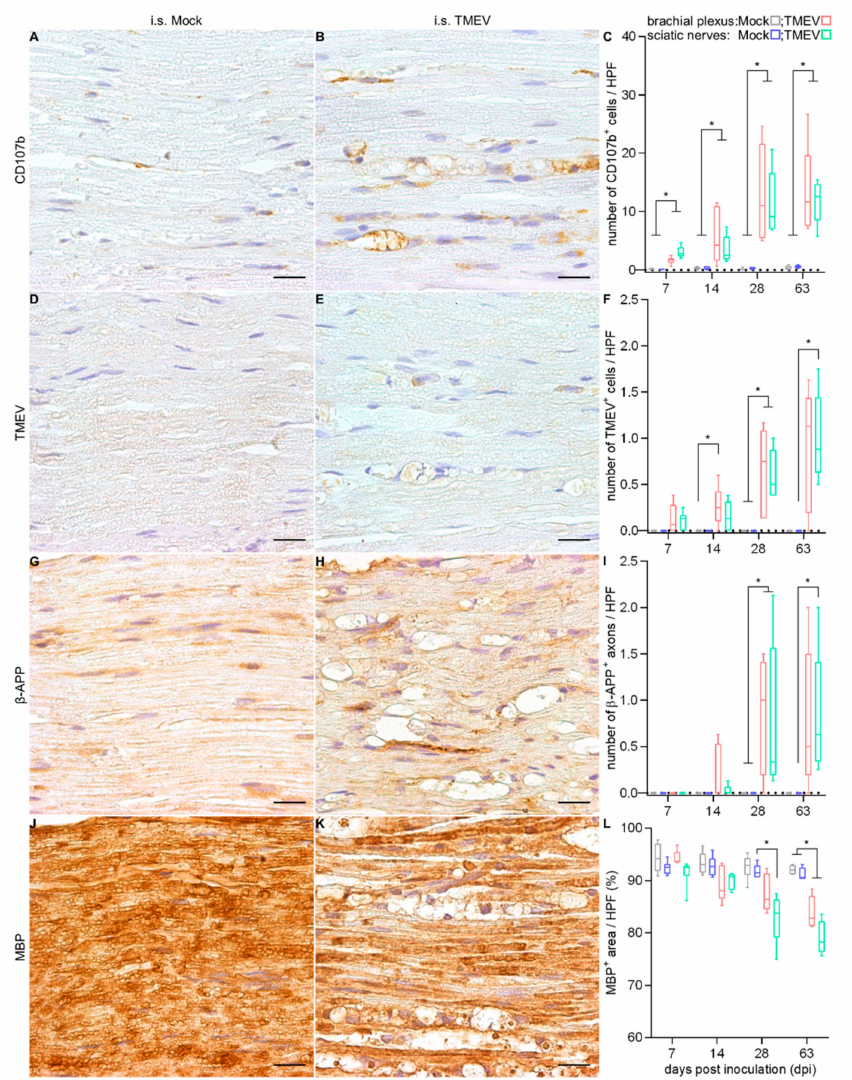
Figure 6. Detection of macrophages and myelinophages, TMEV, axonal damage and demyelination at 28 dpi in PN following i.s. mock-injection ( A , D , G , J ) and TMEV infection ( B , E , H , K ). Statistical analysis revealed a significant increase in the number of CD107b + macrophages ( C ) at all investigated time points. Virus protein was firstly detected at 7 dpi, while significant di ff erences started at 14 dpi ( F ). Significant axonal damage ( I ), as well as demyelination ( L ) following i.s. TMEV infection were initially seen at 28 dpi. Graphs show the average of left and right brachial plexus or sciatic nerves, respectively. Box-and-whisker plots show median and quartiles. Significant di ff erences between the groups as detected by a Mann–Whitney U-test are indicated by asterisks (* p < 0.05). Bars represent 20 µ